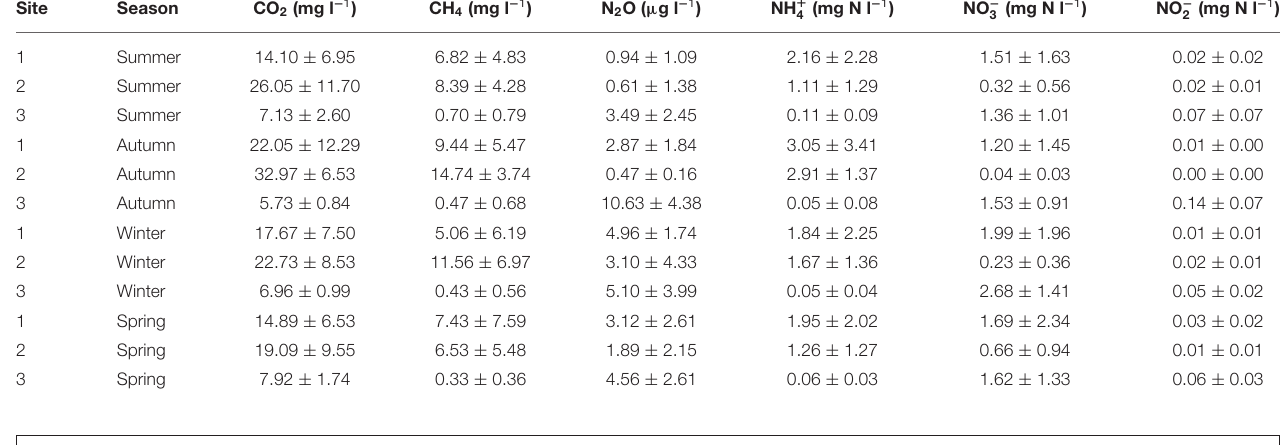
TABLE 3 | The mean and one standard deviation of streambed nutrient and greenhouse gas concentrations across sites and seasons. Site